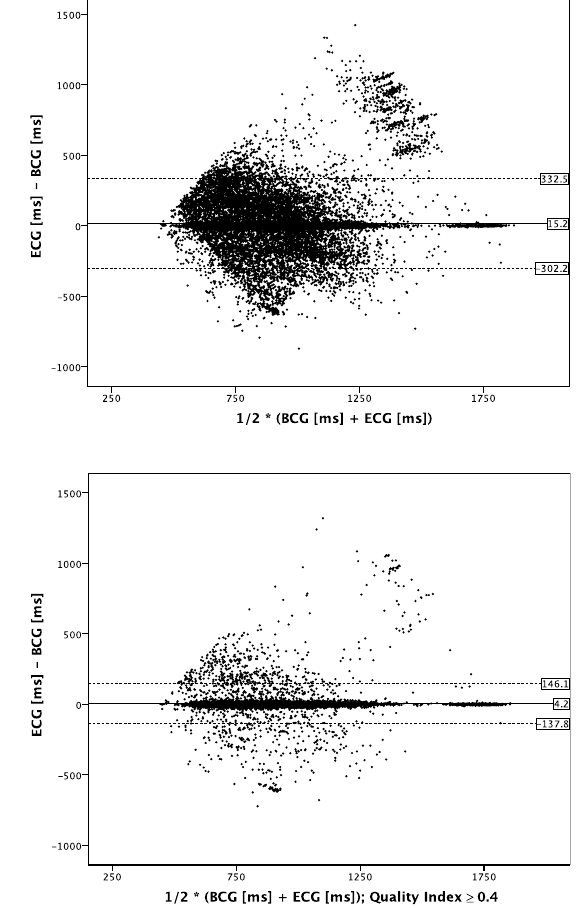
Figure 2. Bland-Altman plots of the analysed heartbeats. To generate the plots, 10% of all recorded heartbeats (n = 326040) were randomly selected to avoid clutter. ( A ) Mean differences of all analysed heartbeats for BCG and ECG. The mean difference of simultaneously recorded heartbeats for ECG and BCG is 15 ± 162 ms. ( B ) Mean differences of all analysed heartbeats for BCG and ECG filtered with QI ≥ 0.4. The mean difference for simultaneous recorded heartbeats is 4 ± 72 ms after filtering. By filtering for better signal quality, the BCG cycle length detection improves accuracy at the cost of the absolute number of analysable